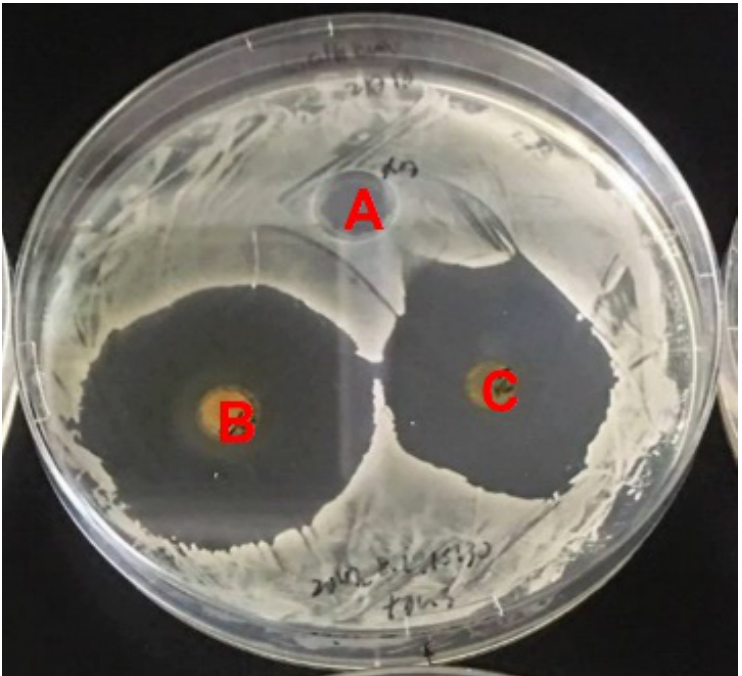
Figure 1. Antifungal activity of an extract from S. achromogenes subsp. streptozoticus NBRC14001. Candida albicans was used as a test organism. A, methanol (control); B, n -butanol extract from the